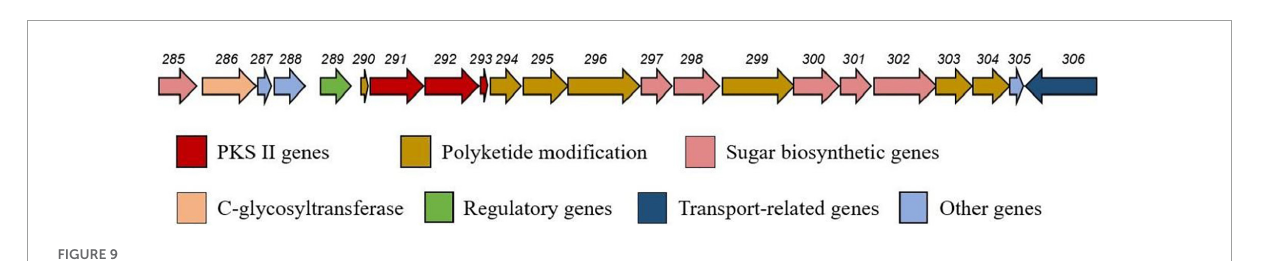
FIGURE9 Organization of the biosynthetic gene cluster predicated for mayamycins in